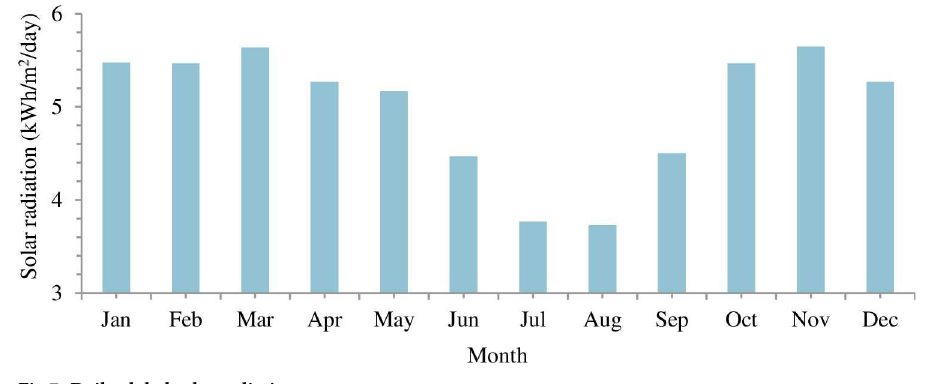
Fig 7. Daily global solar radiations.